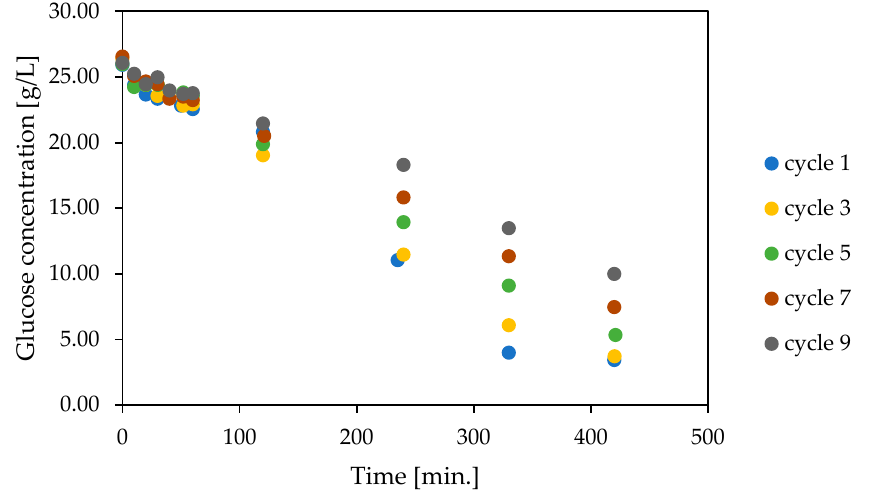
Figure 5. The re-using of co-encapsulated glucose oxidase and catalase, (glucose 27.5 g/L, GOX 1.38 g/L, CAT 0.22 g/L, capsules volume 3 mL, total volume 18 mL, 0.1 M HEPES buffer pH 6.6, 12 °C, CaCO 3 4 g/L, compressed air).